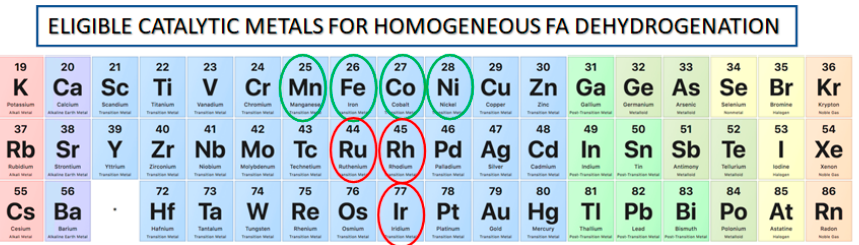
Figure 8. Eligible metals as catalysts for FA dehydrogenation. Noble metals = Ru, Rh, Ir. Non-noble metals = Mn, Fe, Co, Ni.